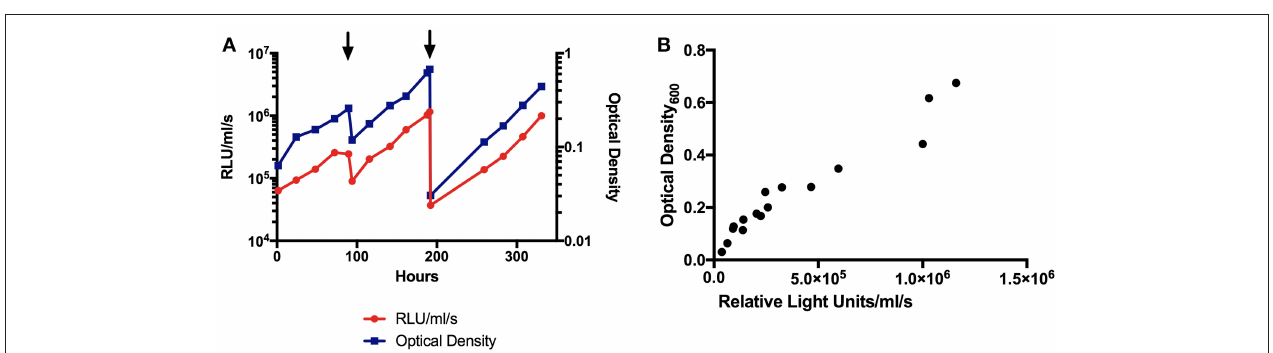
FIGURE 2 | (A) Luminescence and optical density growth curves of BCG-GFP-LuxFO in liquid culture. Luminescence is shown on the left y axis, indicated in red, and optical density on the right y axis, indicated in blue. Arrowheads denote addition of media to maintain bacteria in logarithmic growth phase. (B) Correlation between optical density and luminescence measurements of BCG-GFP-LuxFO in 7H9 liquid medium. n = 16 pairs of observations. Spearman rank correlation coefficient, r = 0.9853 (95% CI:0.9556:0.9952; p < 0.0001). RLU, Relative Light Units.